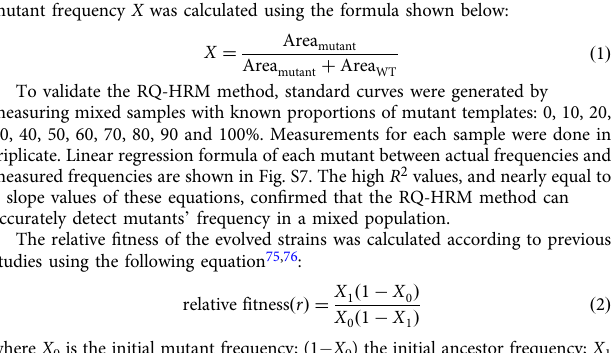
Supplementary Table S3. Raw sequencing data for this study are deposited at the NCBI database under BioProject PRJNA473919. Relative competitive fi tness of gac mutants measured in vivo and in vitro . The relative competitive fi tness of selected gac mutants was measured in direct com- petition with their direct ancestors both in vivo in the rhizosphere of A. thaliana and in vitro in different standard culture media. Relative fi tness was measured as deviation from initial 1:1 ratio of bacterial clone pairs based on PCR-based high- resolution melting pro fi le (RQ-HRM) analysis. Three pairs of isolates were selected: (A) evolved gacA ID 242 (genotype oafA Y335X ∙ RS17350 A77A.fsX14 ∙ gacA D49Y ) and its direct ancestral genotype 133 (genotype oafA Y335X ∙ RS17350 A77A.fsX14 ) from evolutionary line 1; (B) evolved gacA ID 220 (genotype galE V32M ∙ accC E413K ∙ gacA D54Y ) and its direct ancestral genotype 28 (genotype galE V32M ∙ accC E413K ) from line 2; (c) evolved gacS ID 222 (genotype oafA K338S.fsX18 ∙ gacS G27D ) and its direct ancestral genotype 66 (genotype oafA K338S.fsX18 ) from line 3. Bacterial